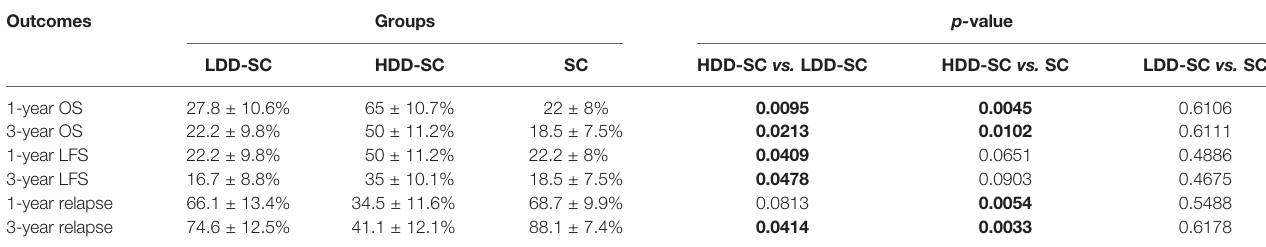
TABLE 2 | Comparison of OS, LFS, and relapse at 1 and 3 years among the HDD-SC group, the LDD-SC group, and the SC group. Outcomes Groups p- value LDD-SC